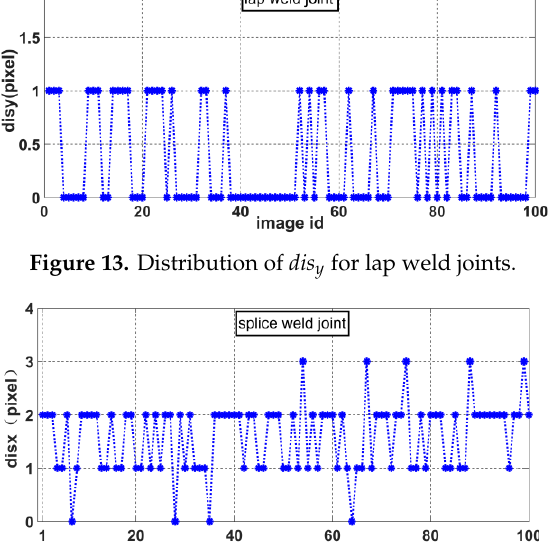
Figure 12. Distribution of dis x for lap weld joints.